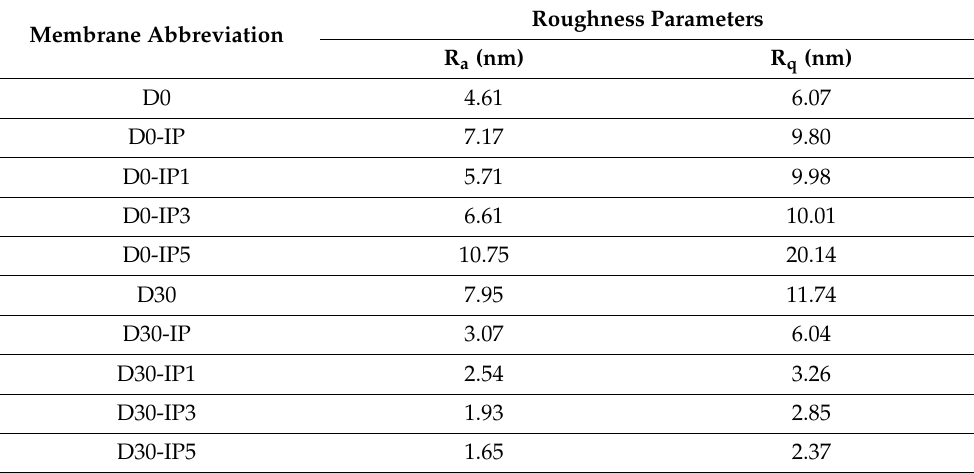
Table 3. Roughness parameters of the selective layer surface of the TFC and TFN membranes.